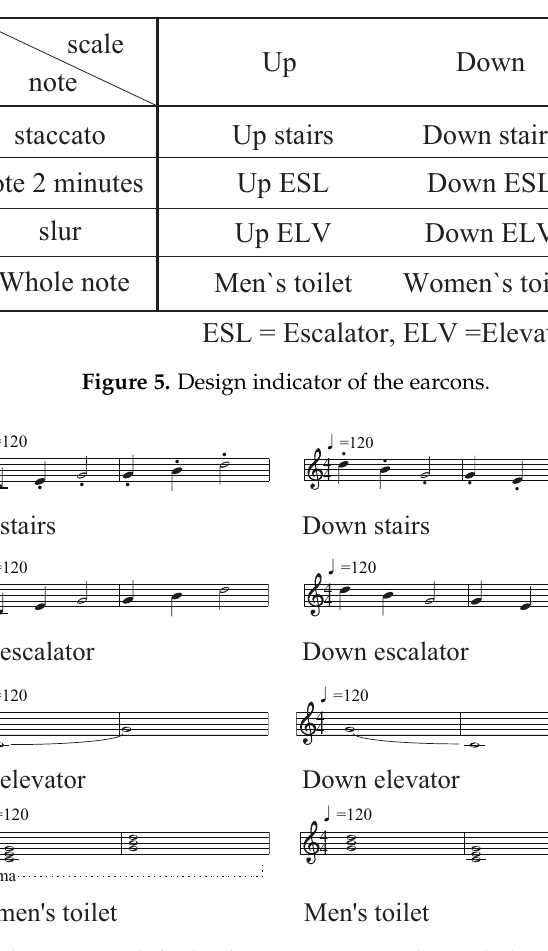
Figure 6. Notes for each earcon: each facility has its own tone color, with the scale going up and down. For the toilet, the musical scale changes according to the